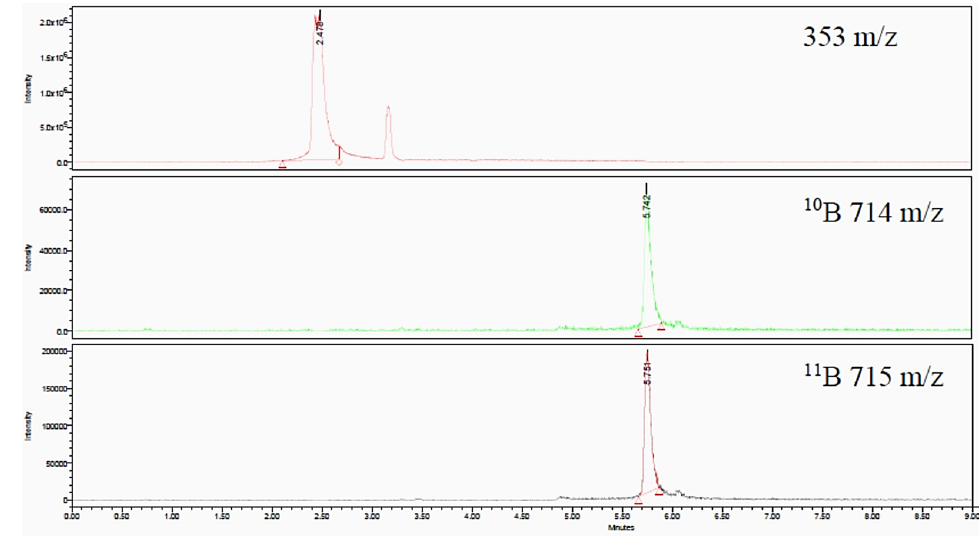
Figure 2. UHPLC/MS confirmation of the identified compounds. MS: Mass spectrometry; UHPLC: Ultra-high-performance liquid chromatography.